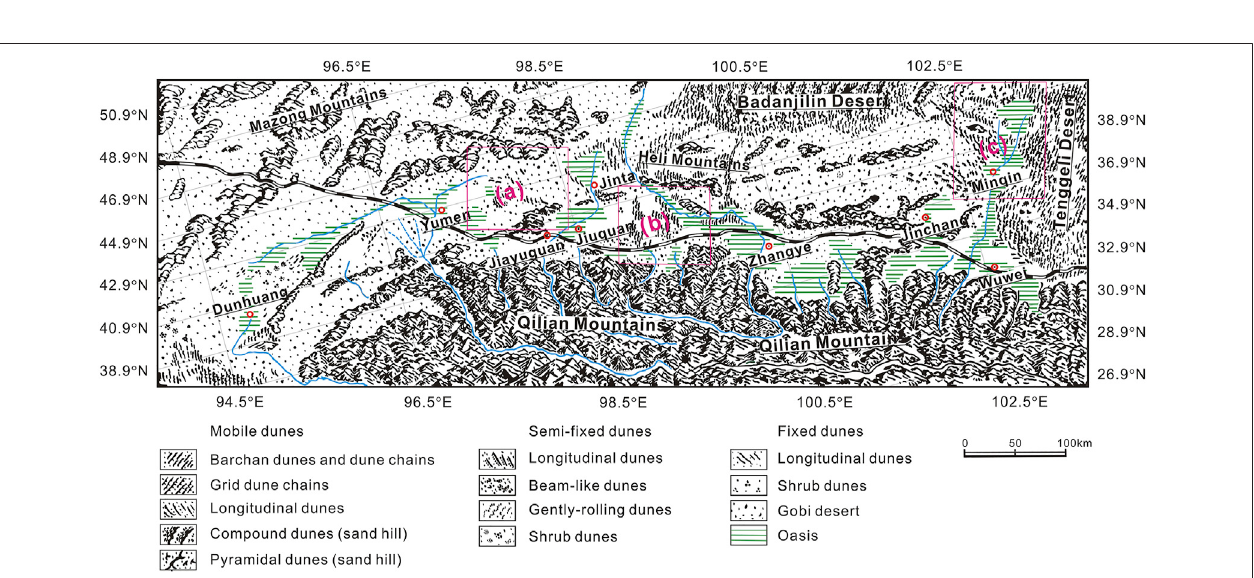
Frontiers in Earth Science |